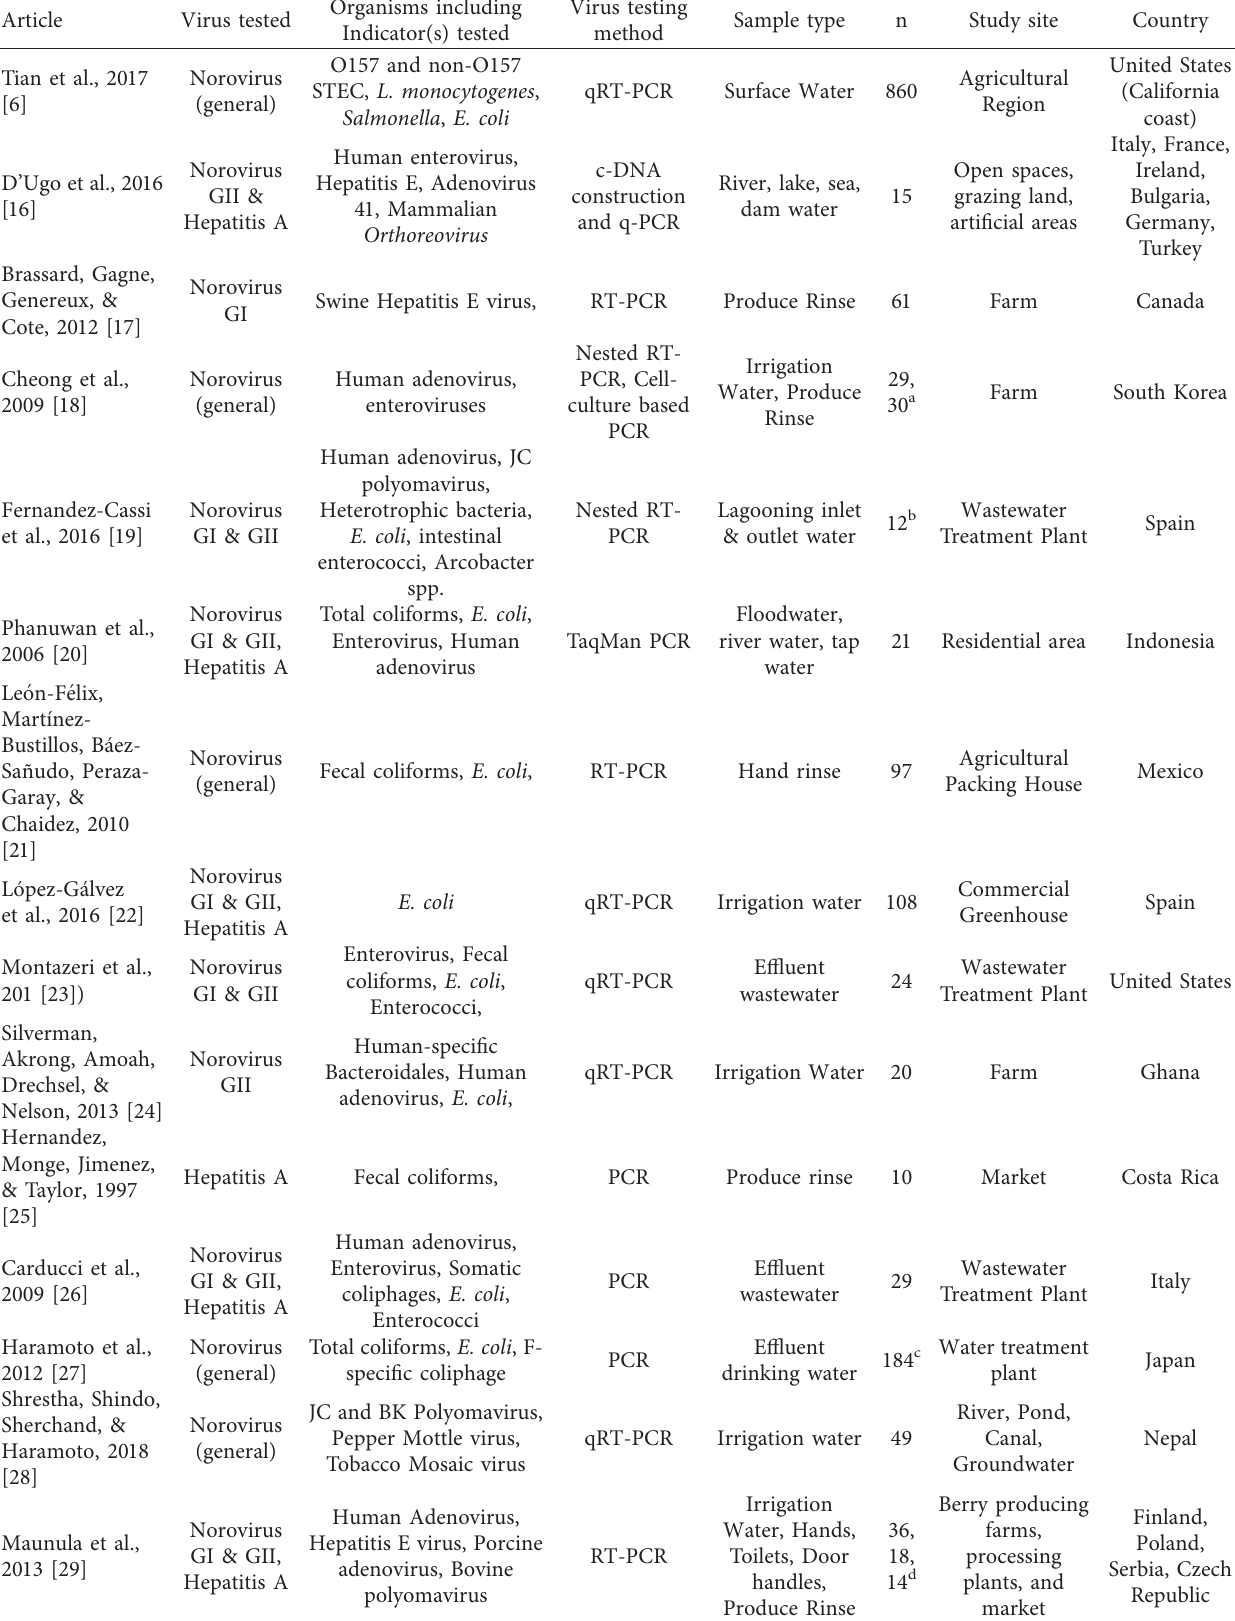
Table 2: Characteristics of included